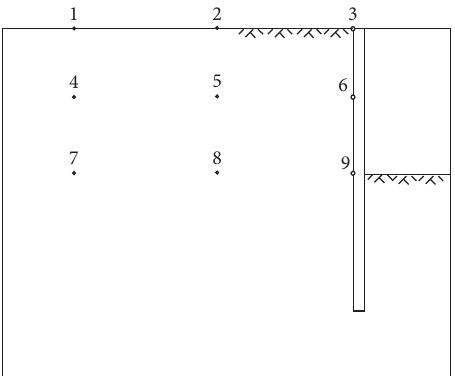
Figure 3: Location of monitoring points.